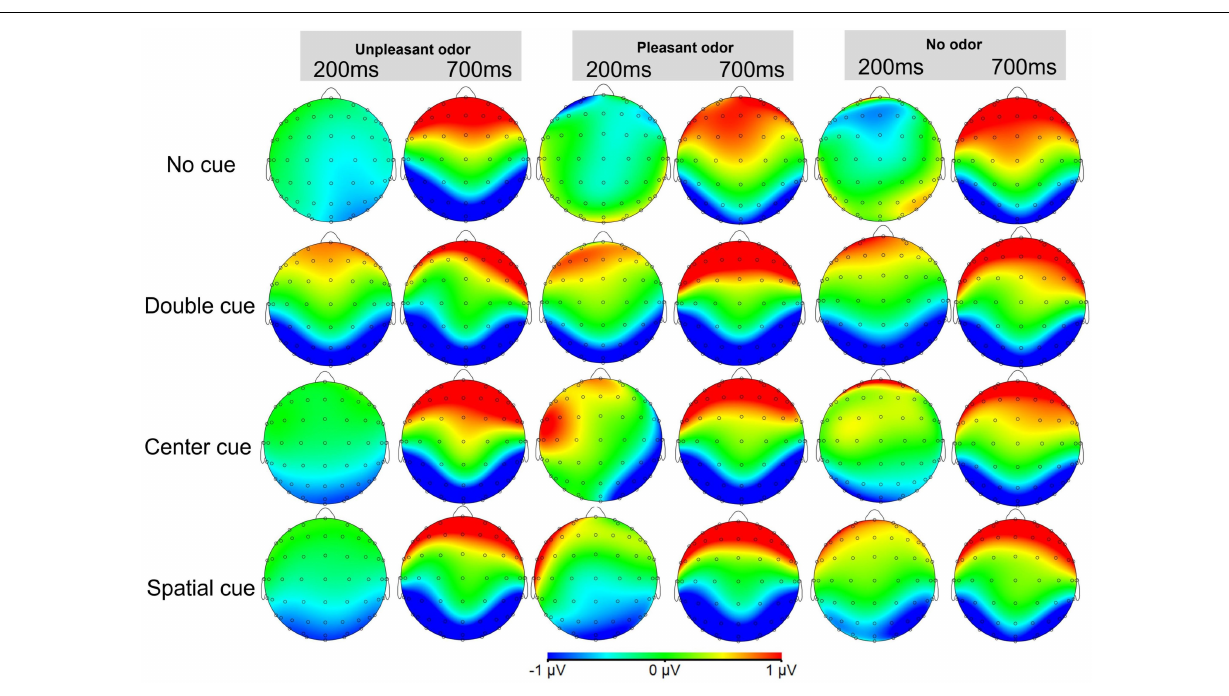
FIGURE 8 | Topographic maps of the voltage differences in the grand-average ERP cue-N1 component (150–250 ms) and target-N1 component (650–750 ms) among the odor